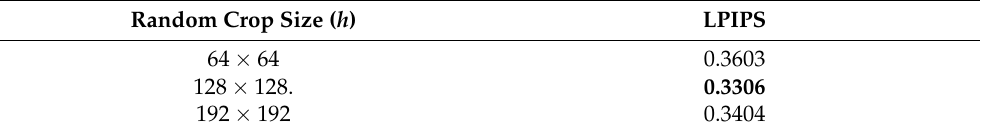
Table A4. Mean value of LPIPS for models with different random crop sizes of input images, where ℎ represents the random crop size of training input images. The best performance in bold.